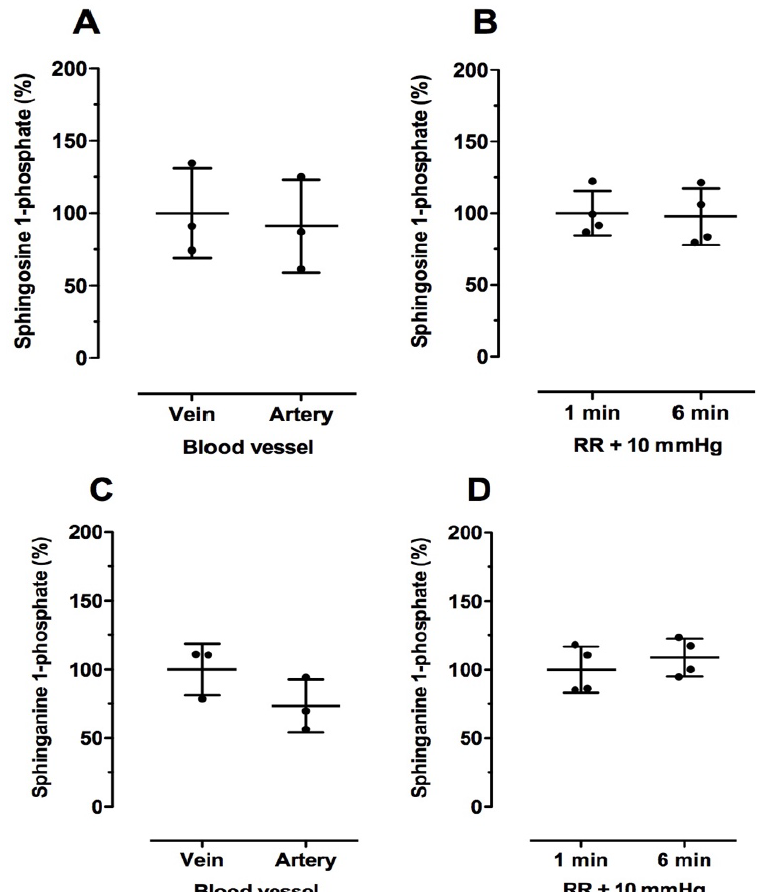
Figure 3. Effect of blood drawing conditions on relative sphingosine 1-phosphate ( A , B ) and sphinganine 1-phosphate ( C , D ) levels in human blood samples. Blood samples were taken from veins and arteries ( A , C ; heparin as anticoagulant) or after 1 min or 6 min RR + 10 mmHg ( B , D ; EDTA as anticoagulant). Thereafter, plasma was directly separated as described in the Material and Methods section. Plasma separated from venous blood ( A , C ) and after 1 min RR + 10 mmHg ( B , D ) served as the respective controls (100%). All plasma samples were stored at − 80 °C until LC-MS/MS analysis. Data are shown as mean (in %) ± SD ( n = 3–4). Table 5. Effect of blood drawing conditions on relative sphingolipid levels in human blood samples.